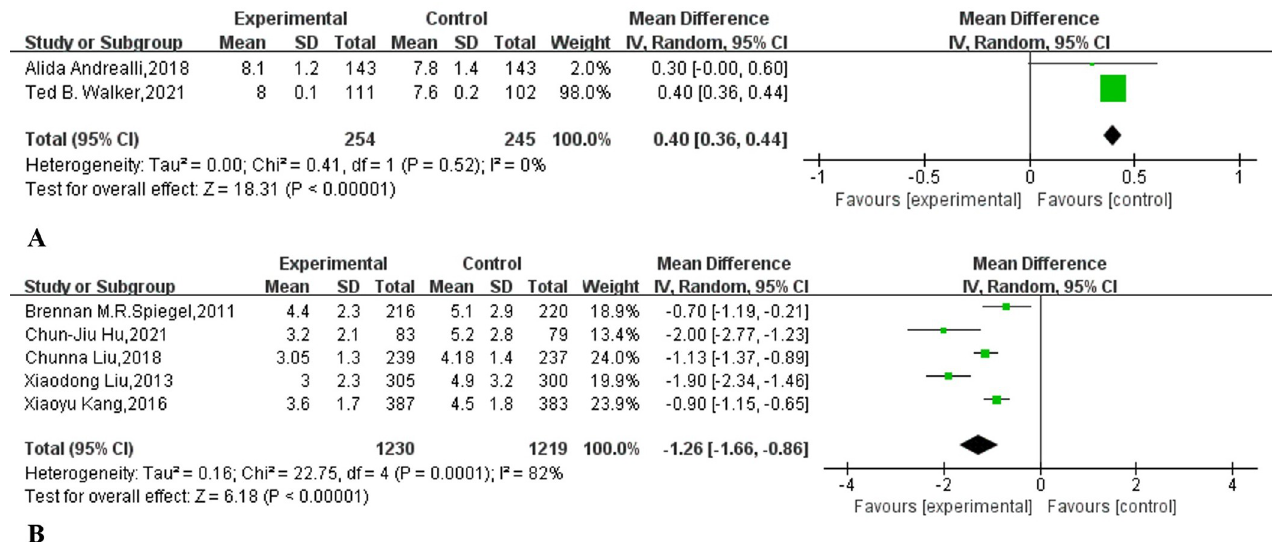
Fig 6. Forest plot comparing (A) the Boston Bowel Preparation Scale (BBPS) and Ottawa Bowel Preparation Quality Scale (OBPQS) supplementary education combined with traditional education and traditional education alone.